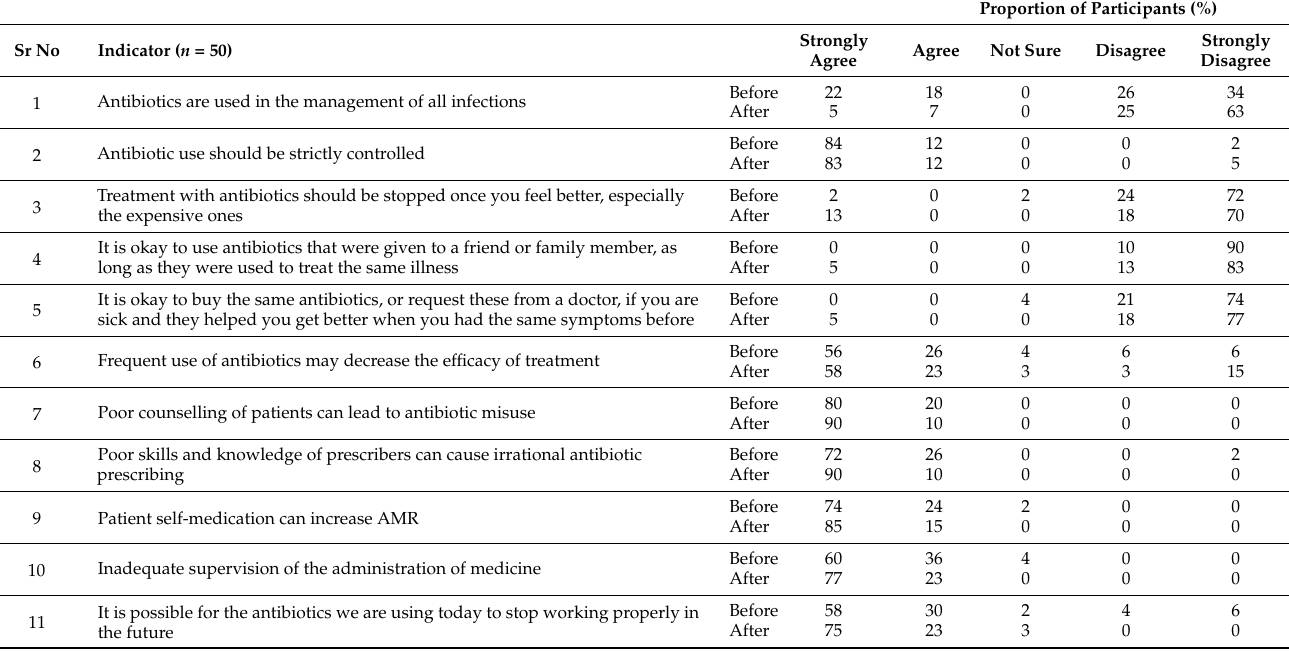
Table 3. General knowledge about